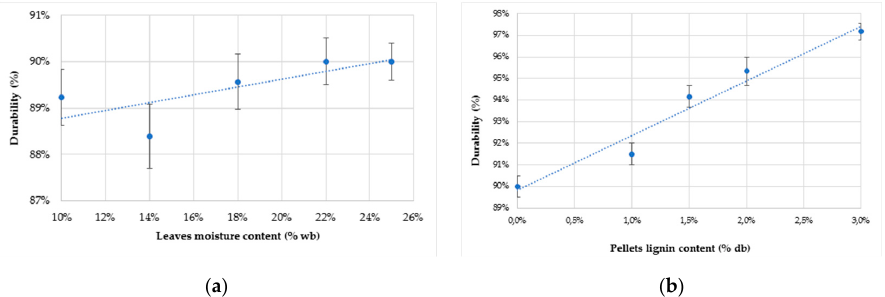
Figure 2. Durability of pellets. ( a ) Influence of the moisture content of leaves, ( b ) influence of the lignin content of pellets.